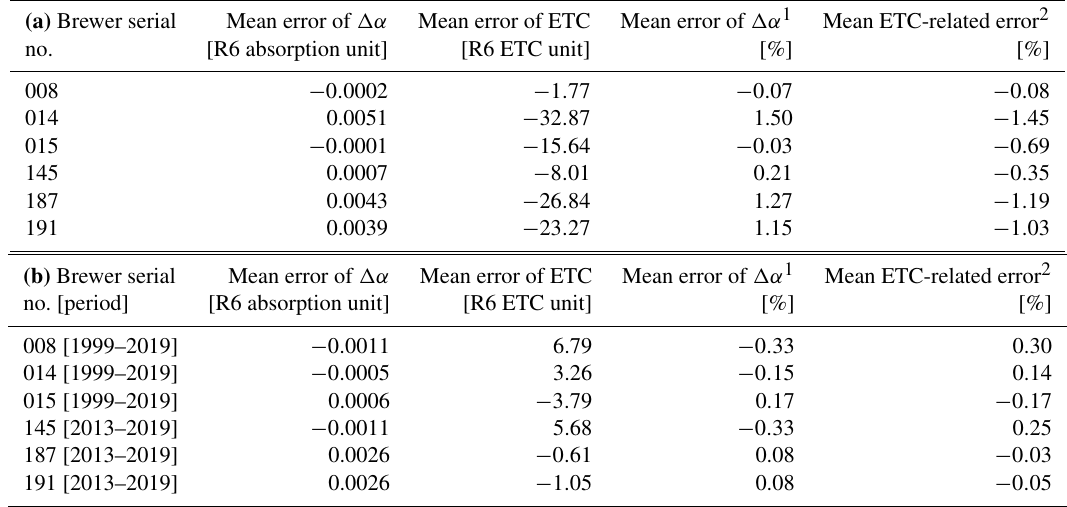
Table 4. (a) Mean errors of (cid:49)α and ETC for Brewer reference instruments (2013–2019) estimated with Model 3. (b) Mean errors of (cid:49)α and ETC for Brewer reference instruments estimated with Model 2.